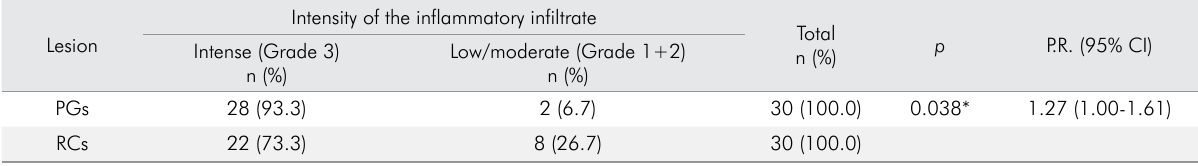
Table 4. Intensity of the inflammatory infiltrate in RCs and